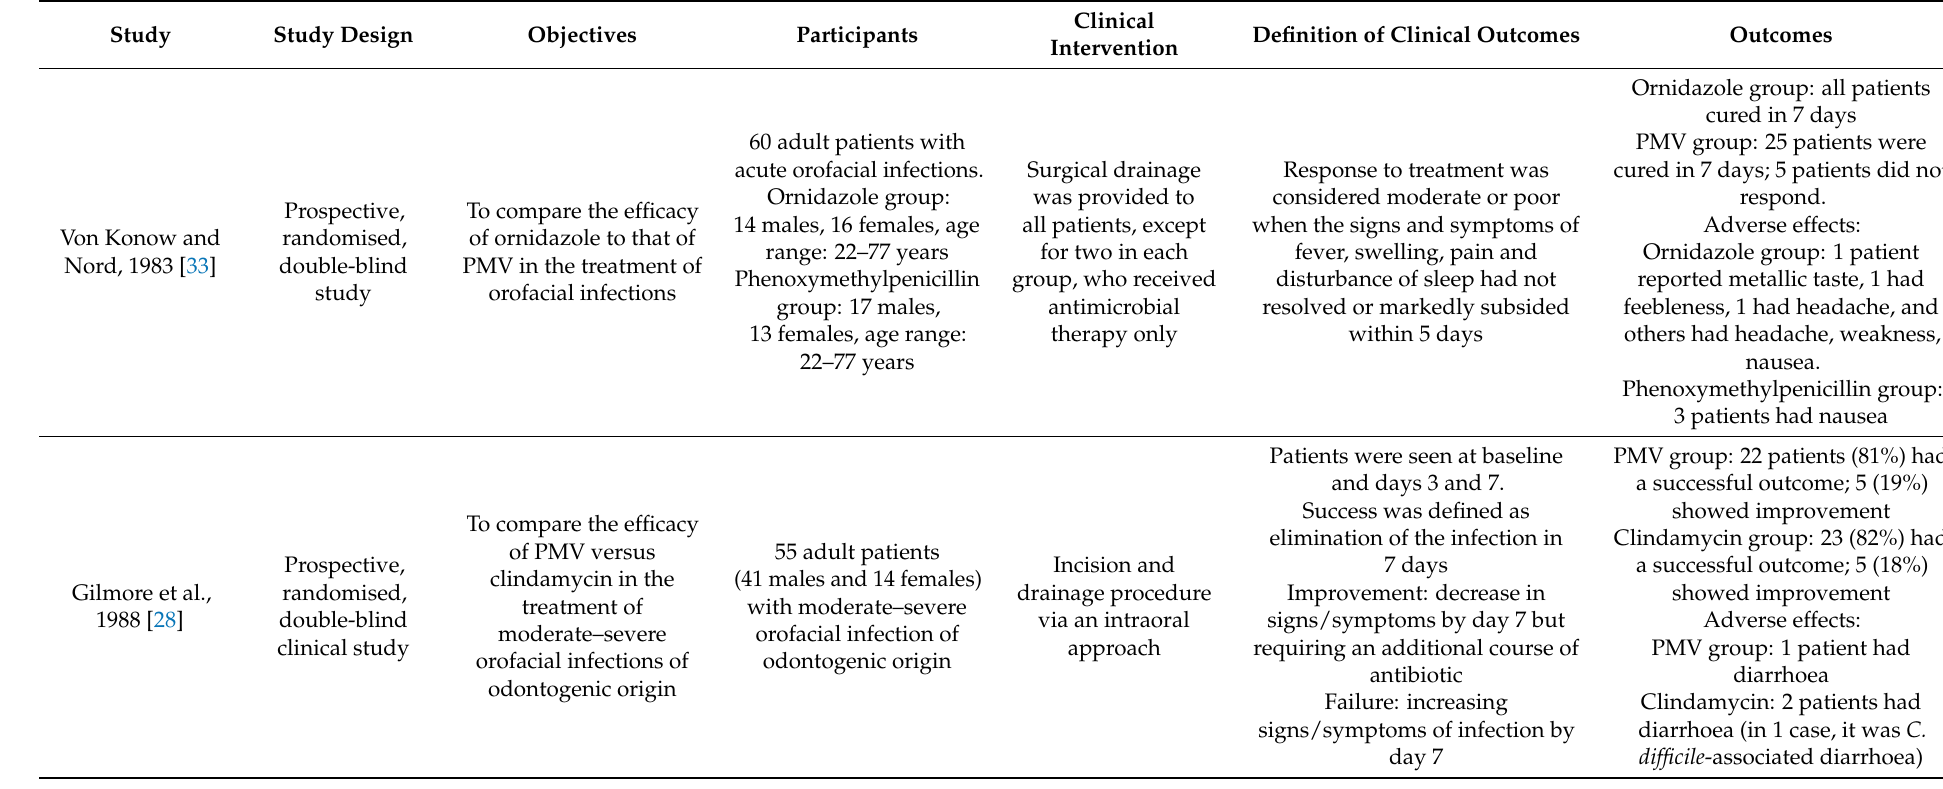
Table 1. Characteristics of the included